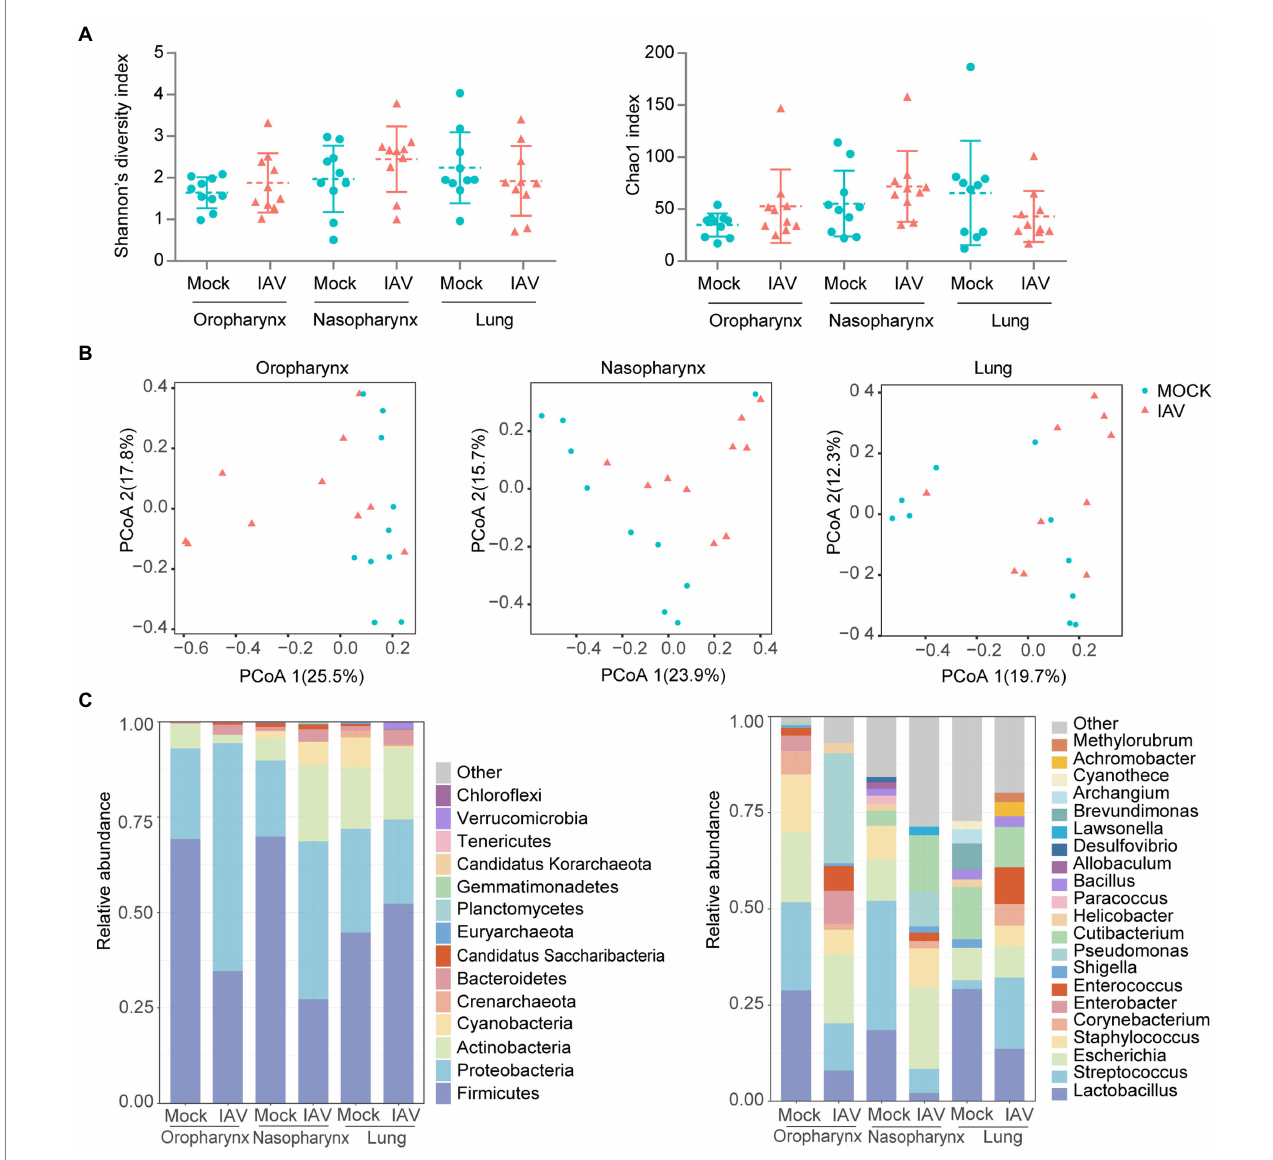
FIGURE 2 Respiratory tract dysbiosis during IAV infection. (A) Shannon diversity and Chao1 indices of oropharyngeal, nasopharyngeal and lung microbiota. (B) 2D-PCoA plots of oropharyngeal, nasopharyngeal and lung microbiota. Relative abundance of the top 10 bacteria at the phylum and genus levels (C) . Shannon and Chao1 indices were analyzed with Mann–Whitney test. * p < 0.05, ** p < 0.01, *** p < 0.001. n = 10 per